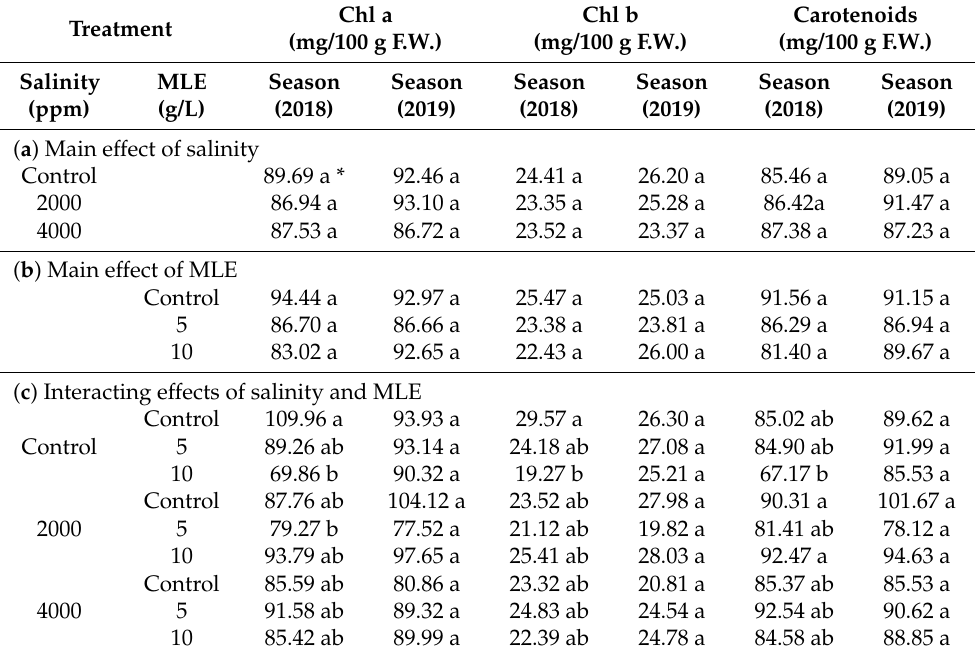
Table 6. Effects of salinity levels, Moringa oleifera leaf extract (MLE) concentrations, and their interac- tions on the compositions (mg/100 g fresh weight of leaves) of chlorophyll a (Chl a), chlorophyll b (Chl b), and carotenoids in S. marianum leaf samples during the 2018 and 2019 planting seasons. Chl a Chl b Carotenoids Treatment (mg/100 g F.W.) (mg/100 g F.W.) (mg/100 g F.W.)